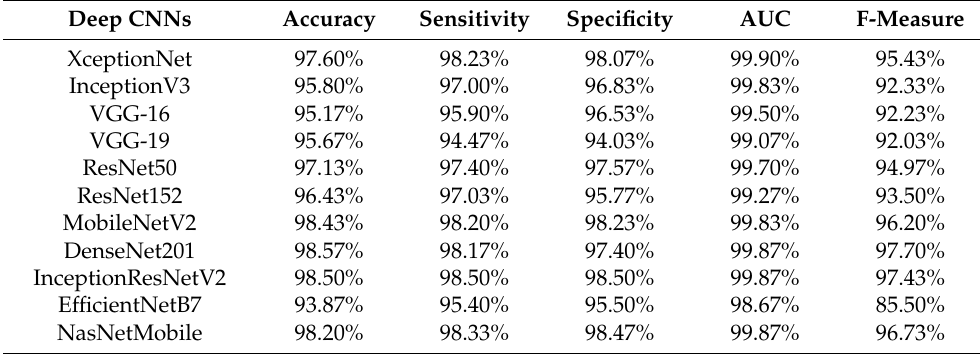
Table 6. Classification results of normal, pneumonia and COVID-19 using cropped lungs and 11 CNNs with Image Augmentation (Approach 2).